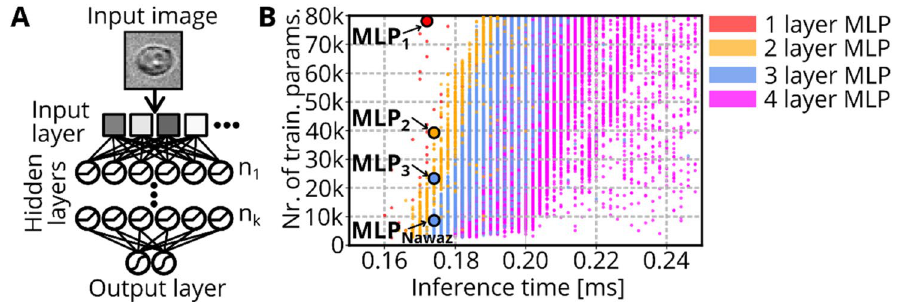
Figure 4. MLP screening. ( A ) Sketch shows general design of multilayer perceptrons. The input layer contains all pixels of the provided image. Each of the following k hidden layers contains n i ( 1 ≤ i ≤ k ) nodes. Each node represents a linear combination of the input values, which is modulated by an activation function (ReLU for the hidden layers and Softmax for the output layer). The output layer returns probabilities for each class of the classification task. ( B ) The scatterplot shows the inference time and number of trainable parameters of 396,521 different MLP architectures with k =1 (red), k =2 (orange), k =3 (blue), k =4 (magenta). Chosen models with identical inference time, but more trainable parameters compared to MLP Nawaz are indicated by MLP 1 , MLP 2 , and MLP 3 .